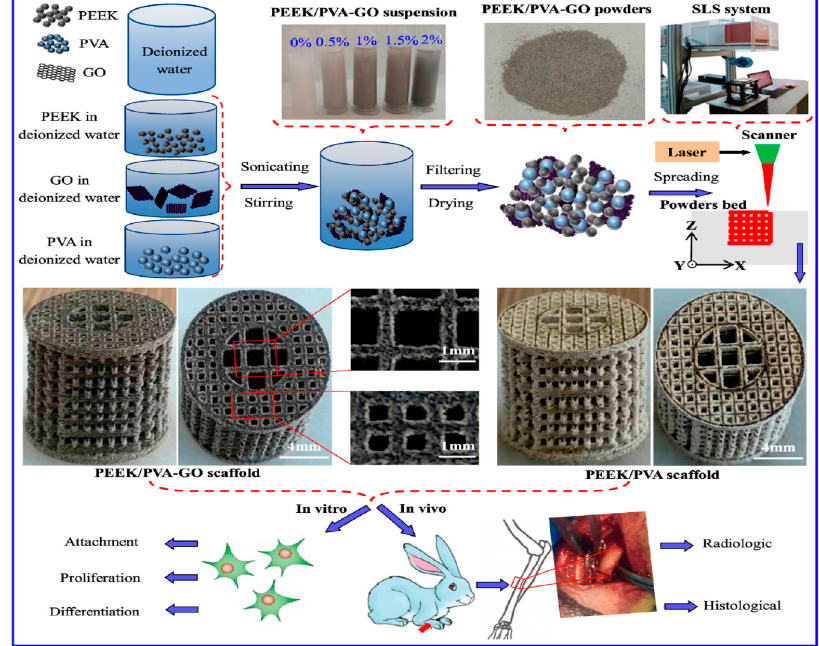
Figure 35. Schematic illustration showing the fabrication of porous PEEK-PVA and PEEK-PVA/GO scaffolds through solution mixing and selective laser sintering. These scaffolds are subjected to in vitro cell culture and in vivo animal model studies. Reproduced from [221] with permission of Taylor & Francis.